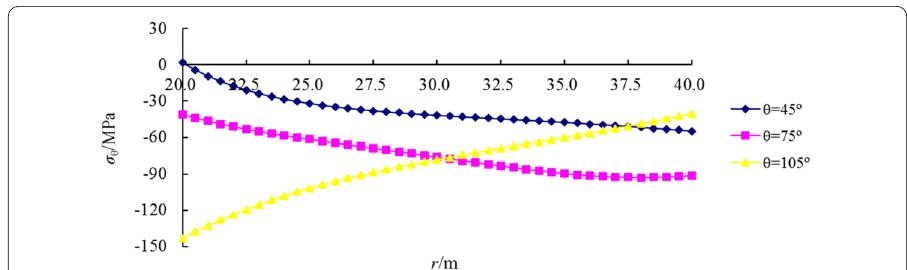
Figure 6 Distribution of circumferential stress for three different sections